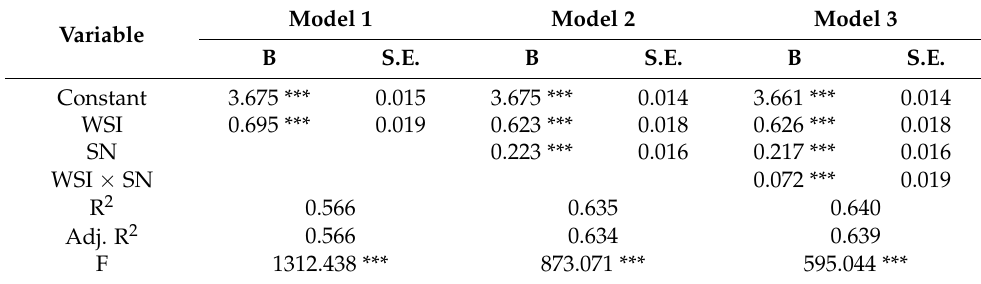
Table 7. Results of the test on the moderating effect of social norms.